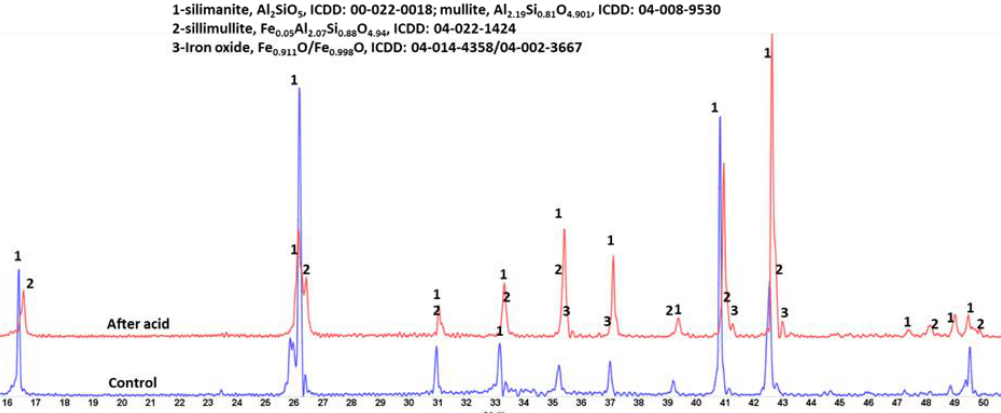
Figure 15. XRD patterns of the control (250 °C autoclaved) and acid-exposed mullite samples. The XRD patterns of crystalline anorthite changed after the acid exposure (Figure